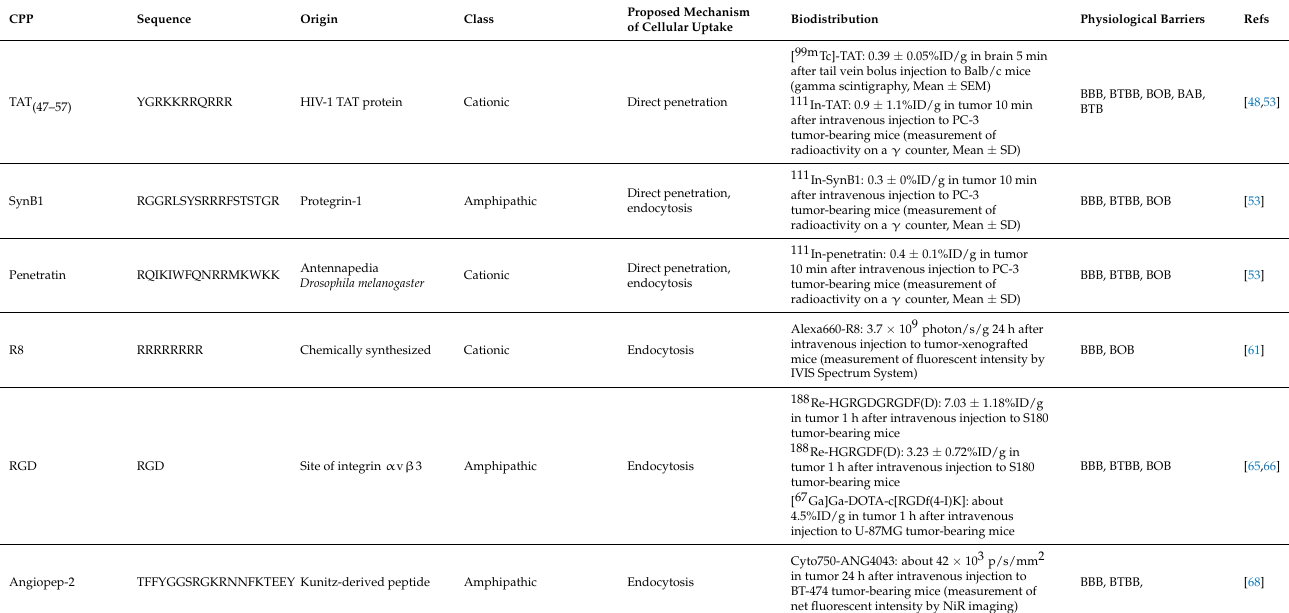
Table 1. Representative CPPs for crossing histohematic